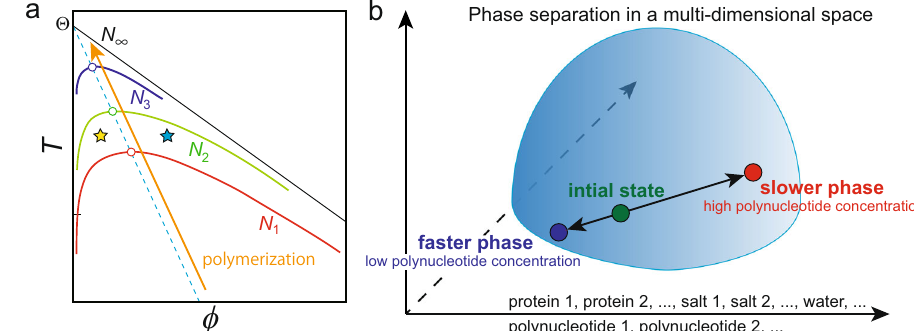
Fig. 4 Dynamic phase diagram of biological phase separation. a Polymerisation-induced phase separation. The phase diagram of a polymer solution moves towards the black line ( N ) with an increase in the degree of polymerisation N from N 1 through N 2 and N 3 ( N 1 < N 2 < N 3 ). T is the temperature, and ϕ is the polymer concentration. With an increase in N , the critical point, ( T c , ϕ ), where T c and ϕ c are the critical temperature and concentration, indicated by c the open circle moves towards the critical point of the polymer solution of N ¼ 1 , ( T c ¼ Θ , ϕ ¼ 0), where Θ is the Θ temperature 52 . The blue dashed line c indicates the N -dependence of the critical point temperature T c of the polymer solution. At the yellow star state point, the minority phase has much slower dynamics than the majority phase upon phase separation driven by polymerisation. In contrast, it is the opposite at the blue star position. The phase- separation behaviour also critically depends on the relationship between the polymerisation-reaction speed and the phase-separation speed. b Schematic phase diagram in a multi-dimensional space. In biological systems made of multi-components, phase separation always occurs in a multi-dimensional space. Multi-phase coexistence is possible, but we consider only a case of two-phase coexistence for simplicity. Upon phase separation, the components of a mixture, such as polynucleotides, proteins, and salts, are divided into two phases. The asymmetric partitioning of high-molecular-weight polymeric components into the two phases should produce a strong dynamic asymmetry between the two phases, leading to